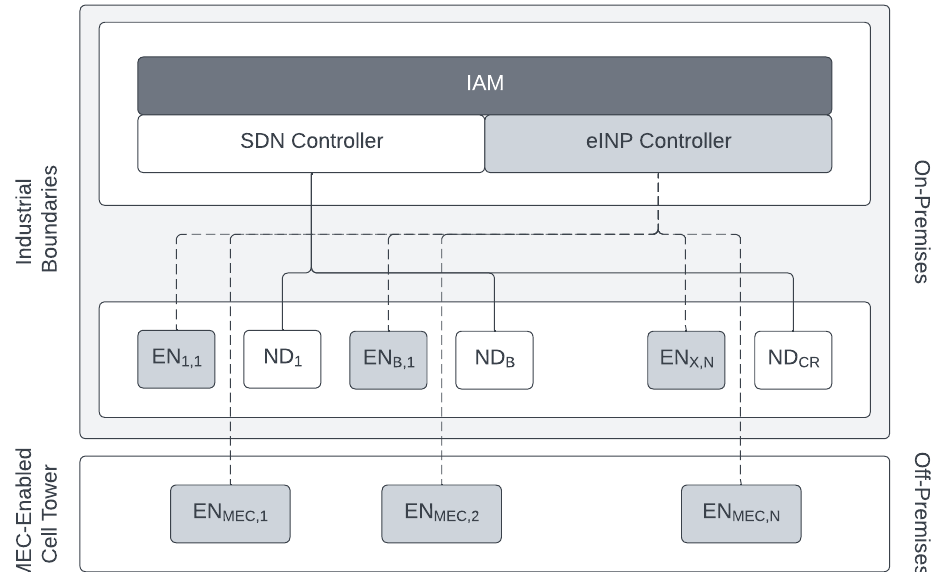
Figure 2. Architecture for enabling application-aware network traffic management. The architecture is based on the SDN-eINP interplay, where the IAM is the glue that makes the SDN and eINP sides work synergically. ENs are available both within (on-premises) and outside (off-premises) the industrial